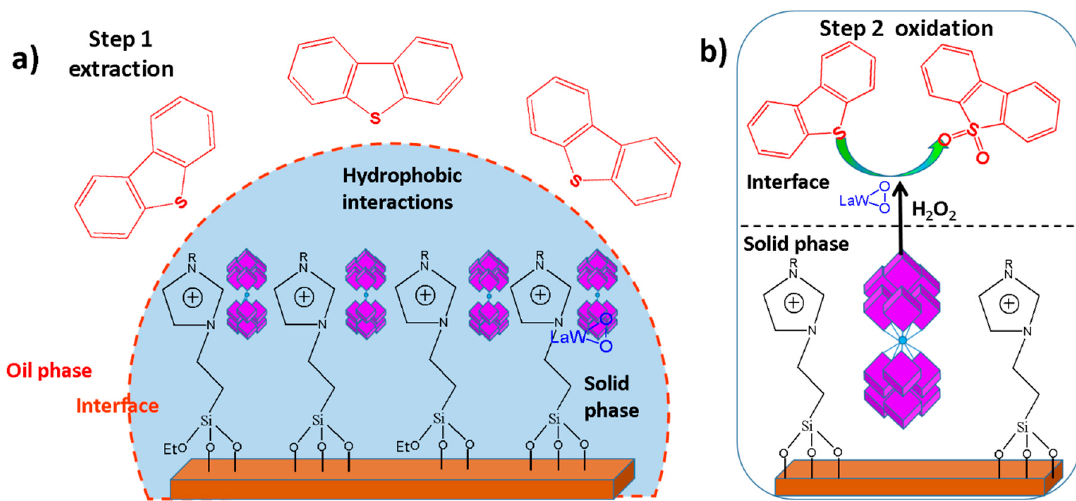
Figure 7. Schematic illustration for the highly selective and efficient removal of sulfur species using LaW 10 / IL-SiO 2 nanocomposites. ( a ) Extraction of the substrate by ionic liquid, ( b ) catalytic oxidation of DBT to DBTO 2 by LaW 10 in the presence of H 2 O 2 (R = − C 8 H 17 ) [128].